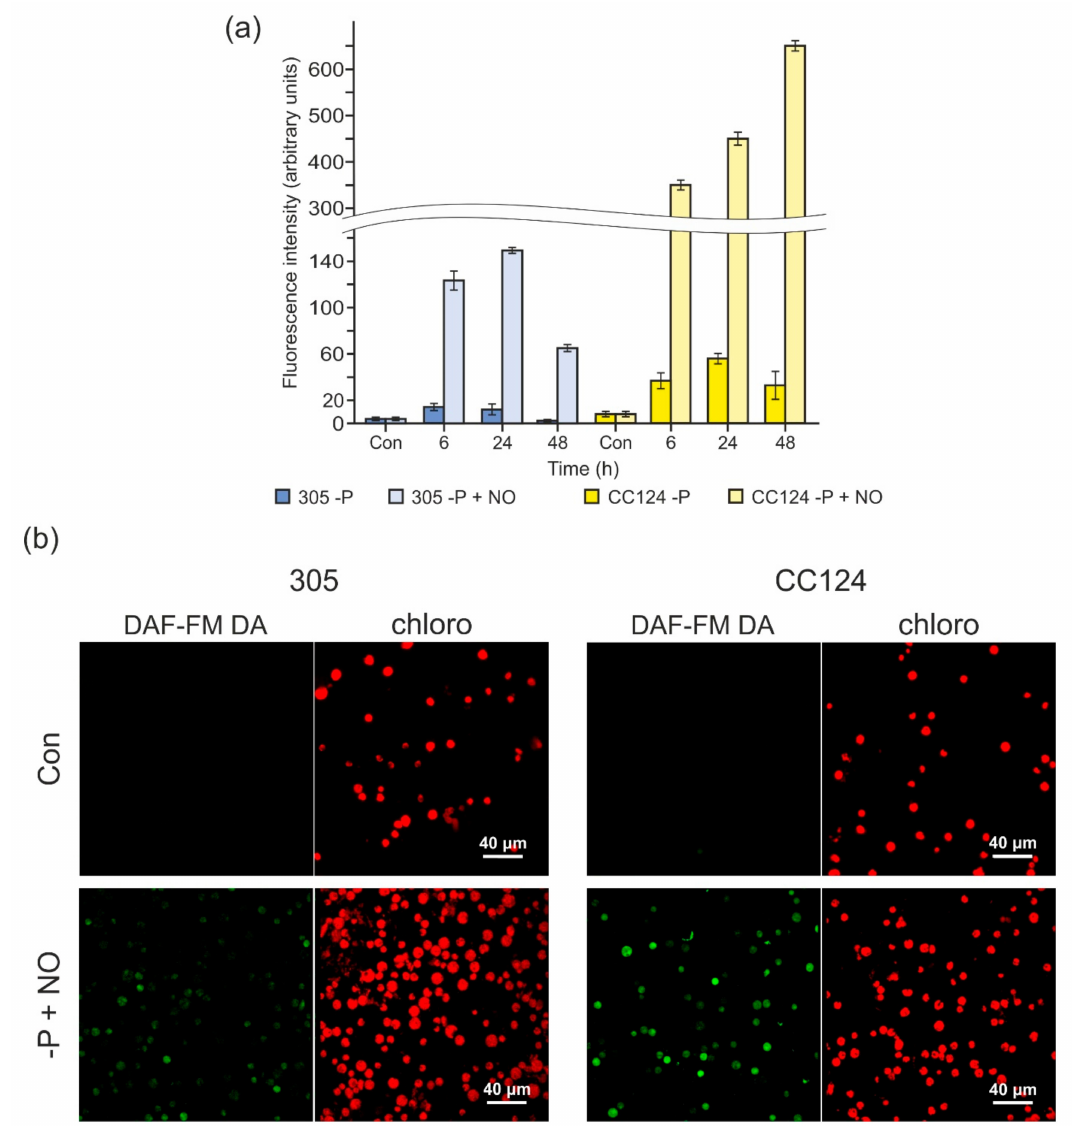
Figure 5. The e ff ects of 2-(N,N diethylamino)-diazenolate 2-oxide sodium salt (DEA-NONOate) on fluorescence intensity in NR-deficient strains upon P deprivation. ( a ) Fluorescence increase by NO treatment (100 µ M DEA-NONOate) was detected in two mutants (305 and CC124) after the removal of P from the medium. DAF-FM DA (1 µ M) was added in the last 15 min. Fluorescence intensity is expressed as arbitrary units per chlorophyll cells 10 − 6 . Cell autofluorescence was subtracted from the total fluorescence obtained. The production of NO was measured by the microplate reader CLARIOstar (BMG). Data are the means ± SE from three biological replicates. ( b ) Visualization by confocal microscopy of DEA-NONOate-induced NO generation in the 305 and CC124 strains. The images show the detected cell populations. In each series, the “Con” panels correspond to cells grown in TAP medium, and the “ − P + NO” panels correspond to cells subjected to P starvation (24 h) and treated with 100 µ M DEA-NONOate (NO). Green indicates the presence of NO, while red fluorescence corresponds to chlorophyll